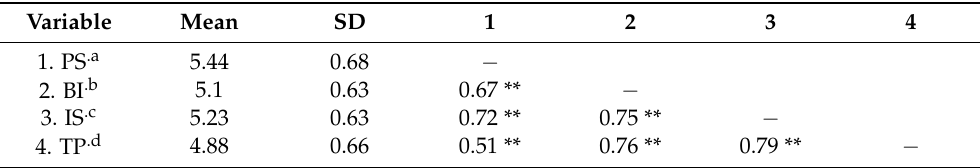
Table 5. Means, standard deviation and partial correlations for variables in H1, H2, H3, H4 and H5 controlled for team size and management team level. n = 160.